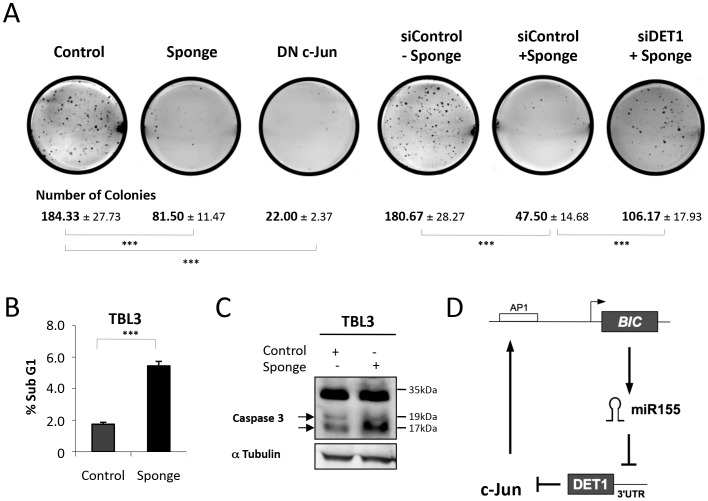
The miR-155/c-Jun loop is essential for growth and survival.
(A) The colony forming potential of TBL3 cells was markedly reduced by transfection with miR-155 Sponge or Dominant Negative (DN) c-Jun. The inhibitory effect of the miR-155 Sponge could be reversed by co-transfection with siRNA inhibiting DET1, compared to a non-relevant scrambled siRNA control. The photographs are representative of three independent experiments and the average number of colonies per plate are indicated (average ± sd, n = 3). ***p<0.001 (B) Representation of flow cytometry analysis indicating the induction of apoptosis (sub-G1 population) of TBL3 expressed miR-155 Sponge (black histograms) (average ± sd, n = 3). (C) miR-155 expression is essential for TBL3 survival. Transfecting TBL3 cells with the inhibitory miR-155 Sponge caused apoptosis as monitored by Western blot detection of Caspase-3 activation. The arrows indicate cleaved activated Caspase-3 (n = 3). (D) A schematic representation of the miR-155/DET1/c-Jun regulatory loop driving oncomiR addiction. The positive feedback loop is provoked by miR-155 repression of DET1 protein translation and DET1-dependent repression of c-Jun protein stability.